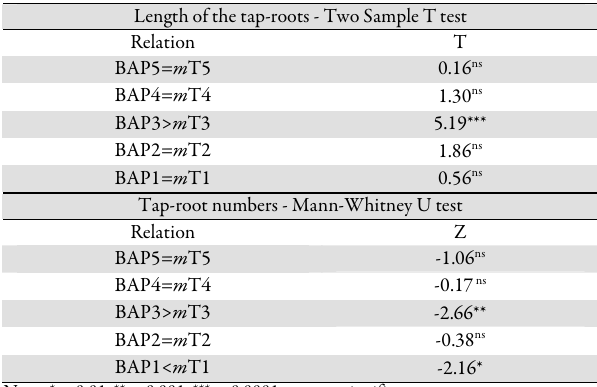
Tab. 3. The tap-root analyses between the two cytokinin treatments in multiplication experiment